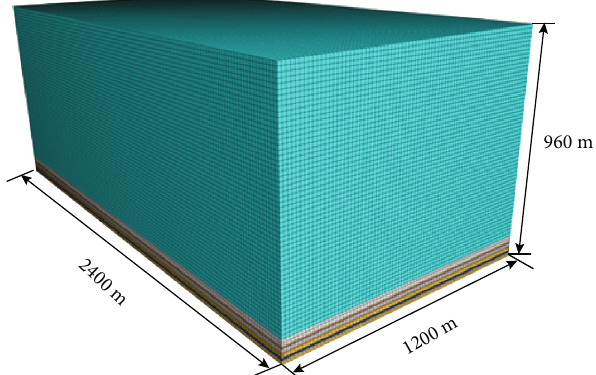
Figure 5: Numerical model